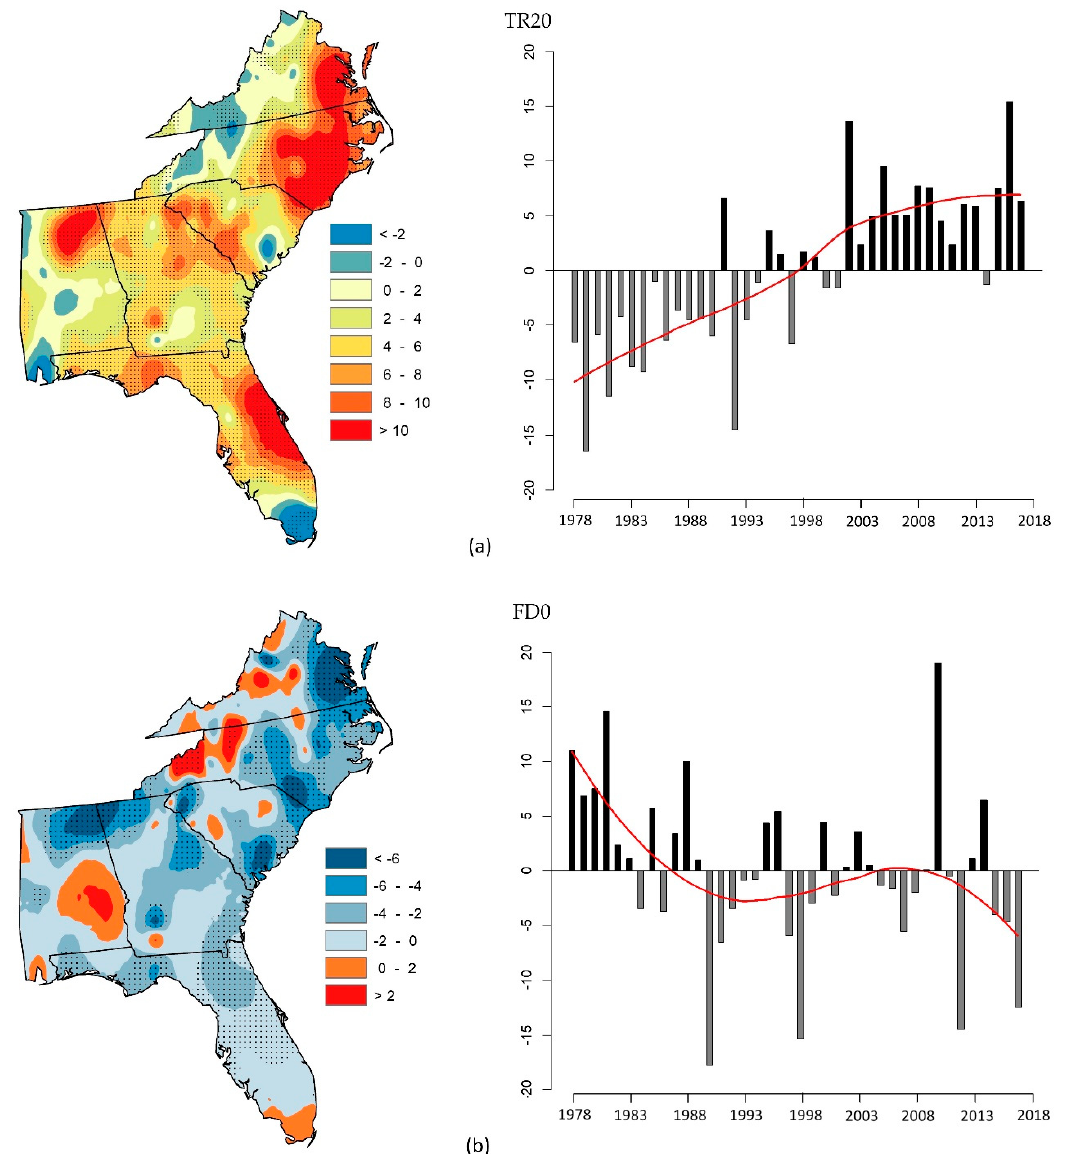
Figure 7. Same as Figure 5, but for threshold indices: ( a ) tropical nights (TR20); ( b ) frost days (FD0). Map units: days per decade; plot units: days.